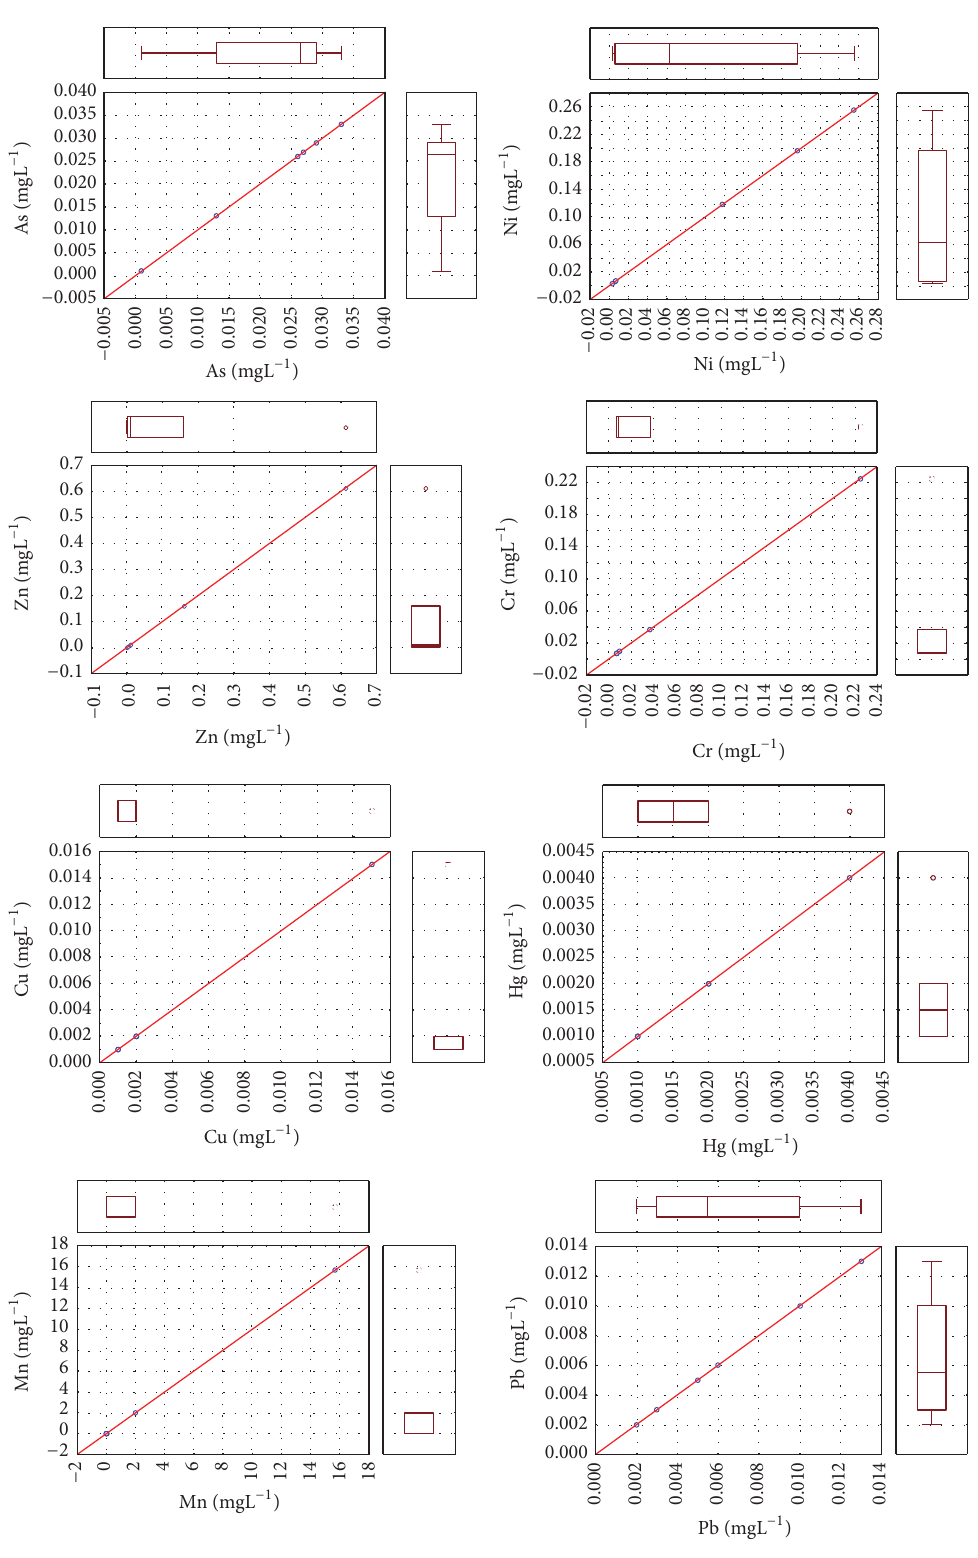
Figure 2: Scatter box plot diagrams of 8 selected heavy metals (mgL −1